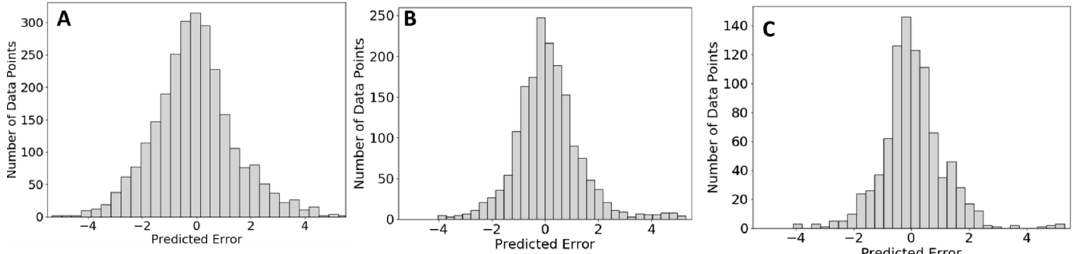
Figure 5. Analysis of error with smaller training sets. This figure shows the data from HILIC-Z with different training set sizes. ( A ). 60 compounds in training sets ( B ). 120 compounds in training set ( C ). 180 compounds in training set. The 180 compound ( C ) uses the same data as Figure 4C.